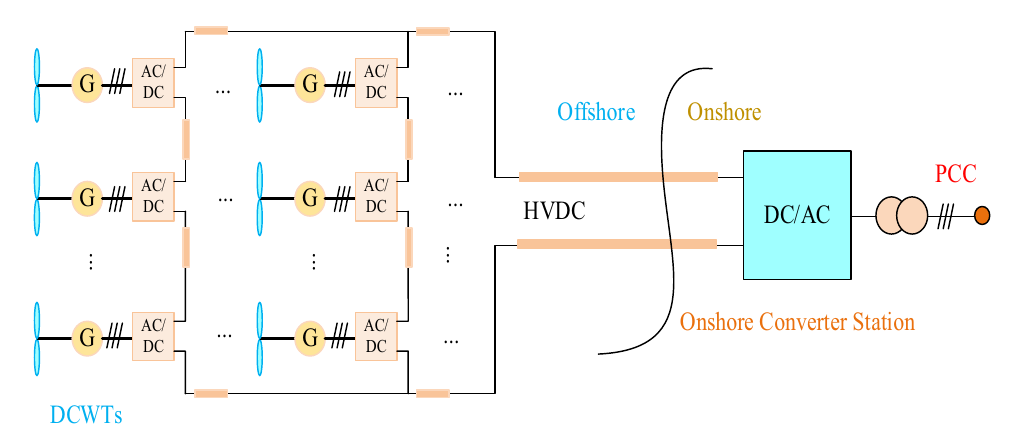
Fig. 13 All-DC OWFs series-connection WTs scheme